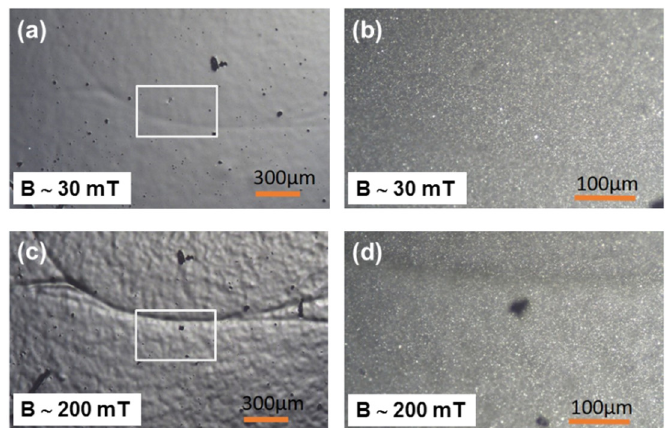
Figure 3. Optical microscopy images of the surface topography of hard MAE with a 70 wt% of CIP: ( a ) B = 30 mT, magnification 5×, ( b ) B = 30 mT, magnification 20×, ( c ) B = 200 mT, magnification 5×, and ( d ) B = 200 mT, magnification 20×.